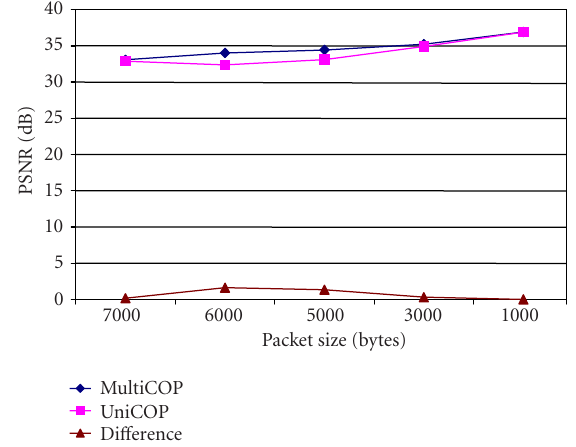
Figure 11: Comparative performance between UniCOP and Multi- COP assignment strategies with (cid:1) = 10 − 5